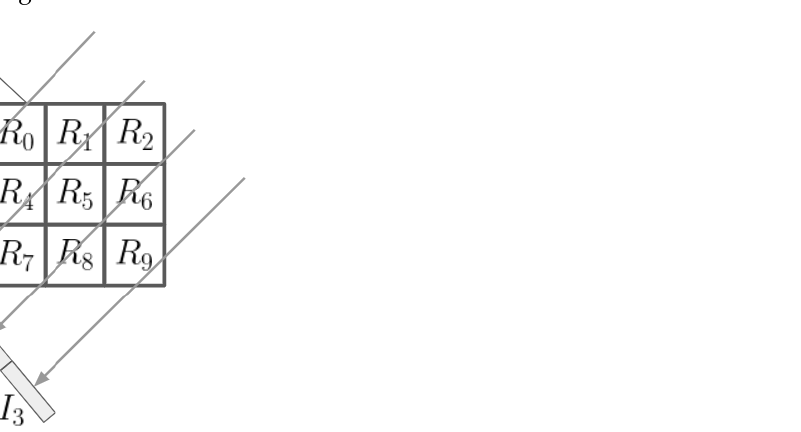
Figure 2. An example of I i X-ray propagation along the pixels R j of a reconstructed image in a parallel